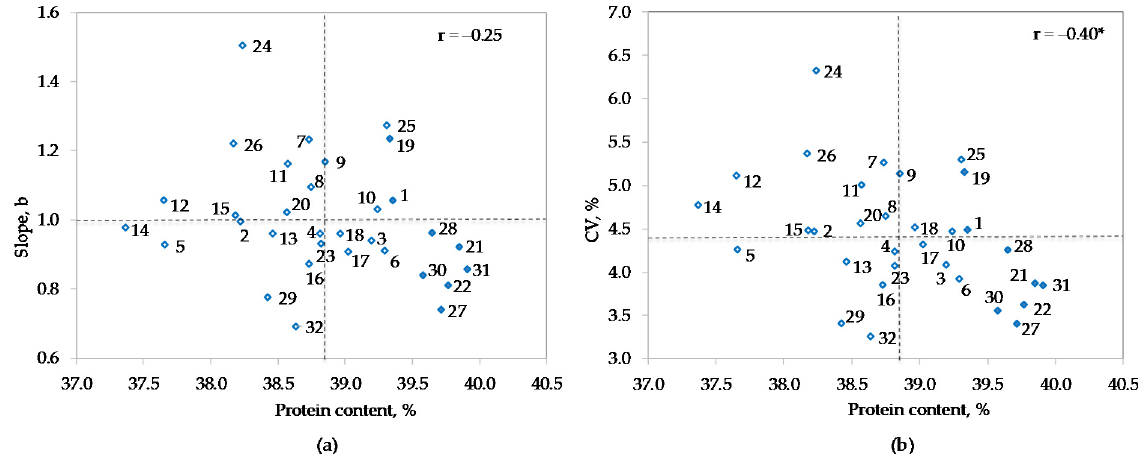
Figure 3. Biplot of the mean protein content of 32 soybean genotypes and their respective slope, b from the regression analysis ( a ) and biplot of the mean protein content of 32 soybean genotypes and their respective coefficient of variation (CV) ( b ). Vertical and horizontal dashed lines represent means across genotypes for protein content and corresponding stability coefficient (b or CV), respectively. The top eight genotypes (with protein content in the first quartile) were shown as filled rectangles. * p < 0.05.